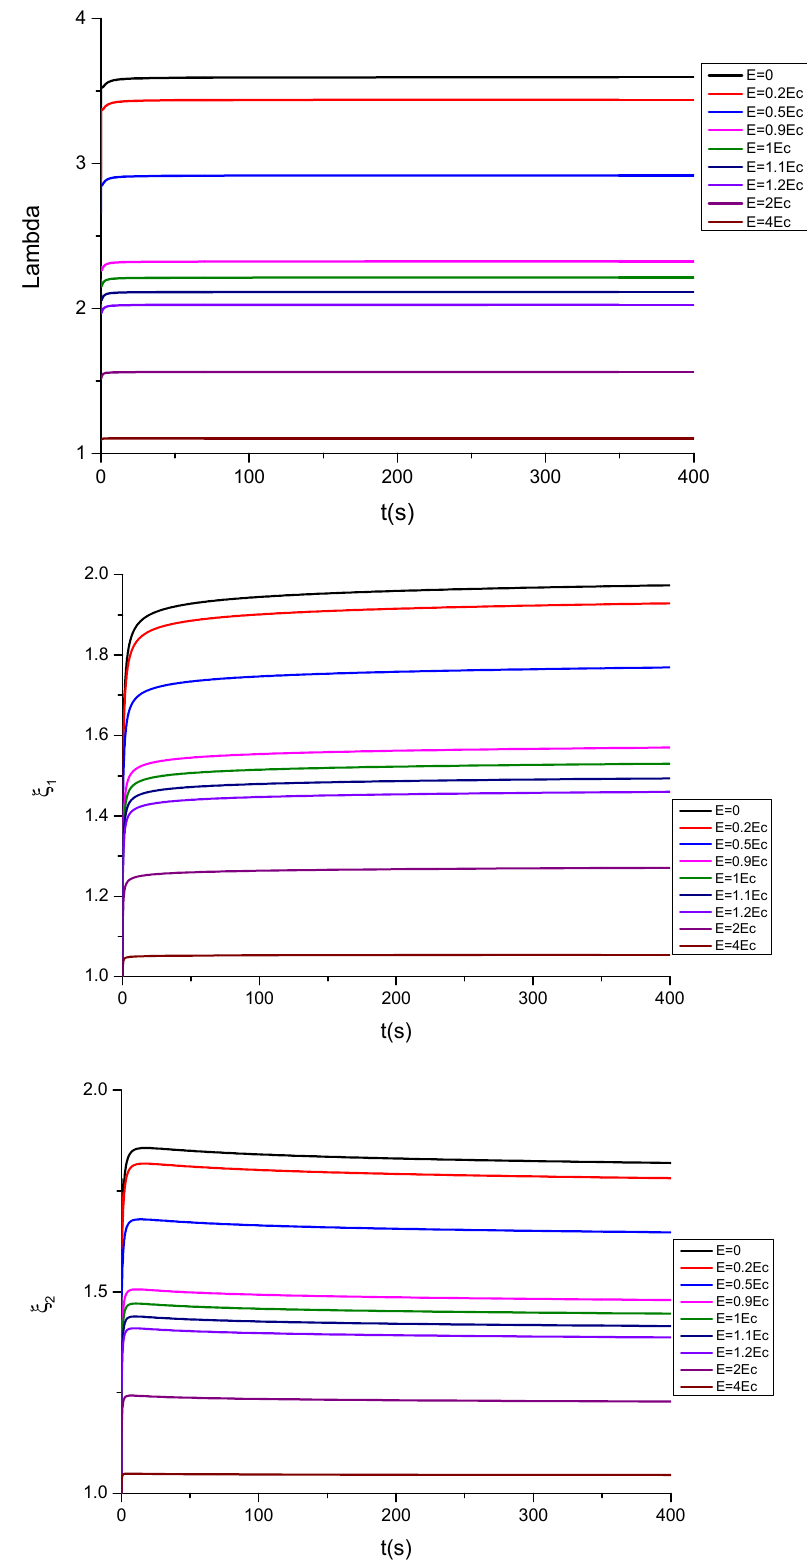
Figure 10. Plot of the bifurcation values of λ , ξ 1 , ξ 2 as a function of time for different values of the electric field E, for the case of a material with an energy function given by Equation (18b) (floating electrodes).